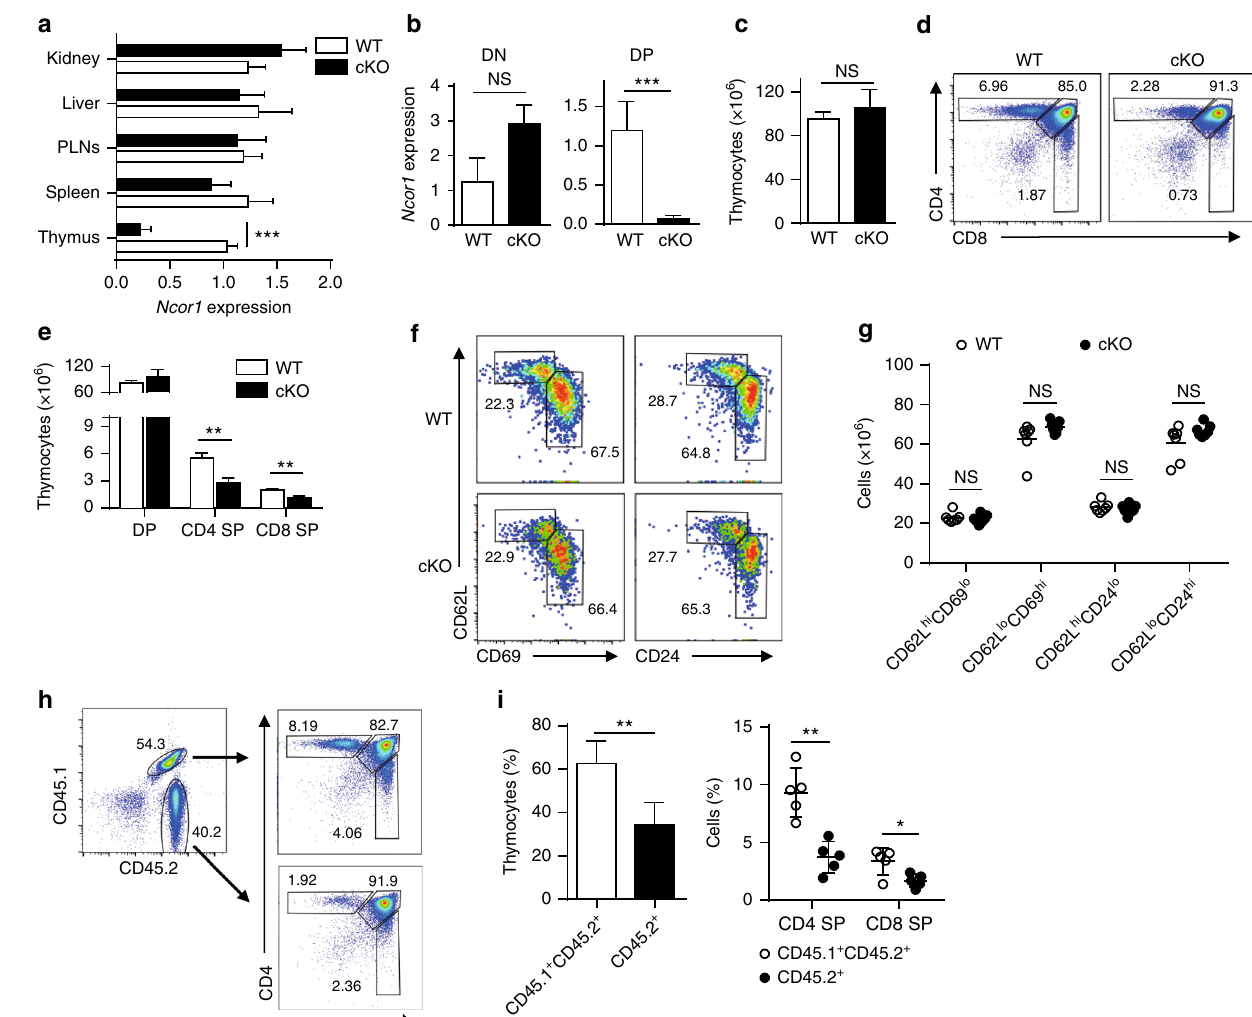
Fig. 1 Late-stage thymocyte development is defective in NCoR1-de fi cient mice. a , b Quantitative RT-PCR analysis of Ncor1 mRNA levels in indicated tissues ( a , n = 5), and sorted CD4 − CD8 − double-negative (DN) thymocytes ( n = 3) and CD4 + CD8 + double-positive (DP) ( n = 6) ( b ) thymocytes from NCoR1-de fi cient (cKO) and wild-type (WT) mice. c , d Total cell numbers ( c ) and surface expression of CD4 and CD8 ( d ) on thymocytes from cKO ( n = 5) and WT ( n = 5) mice detected by fl ow cytometry. e Absolute cell numbers of DP, CD4 + or CD8 + single-positive (SP) thymocytes from cKO and WT mice ( n = 5 for each group), as the product of total thymocytes multiplied by the percentage of cells found in that population. f Expression pro fi les of CD62L vs. CD69 or CD24 on cKO ( n = 3) and WT ( n = 3) CD4 SP thymocytes detected by fl ow cytometry. g Cell numbers of each subpopulation gated in ( f ). h Expression of CD4 and CD8 (right) from mix-bone marrow chimeras generated from CD45.1 +/ − WT and CD45.2 + cKO (left) donors ( n = 4 to 5). i Quanti fi cation of each subpopulation gated in ( h ). The data are representative of two independent experiments ( a , b , h ) or three independent experiments ( c – f ). Statistical signi fi cance was analyzed using the two-tailed Student ’ s t test (* P < 0.05; ** P < 0.01; *** P < 0.001; NS, not signi fi